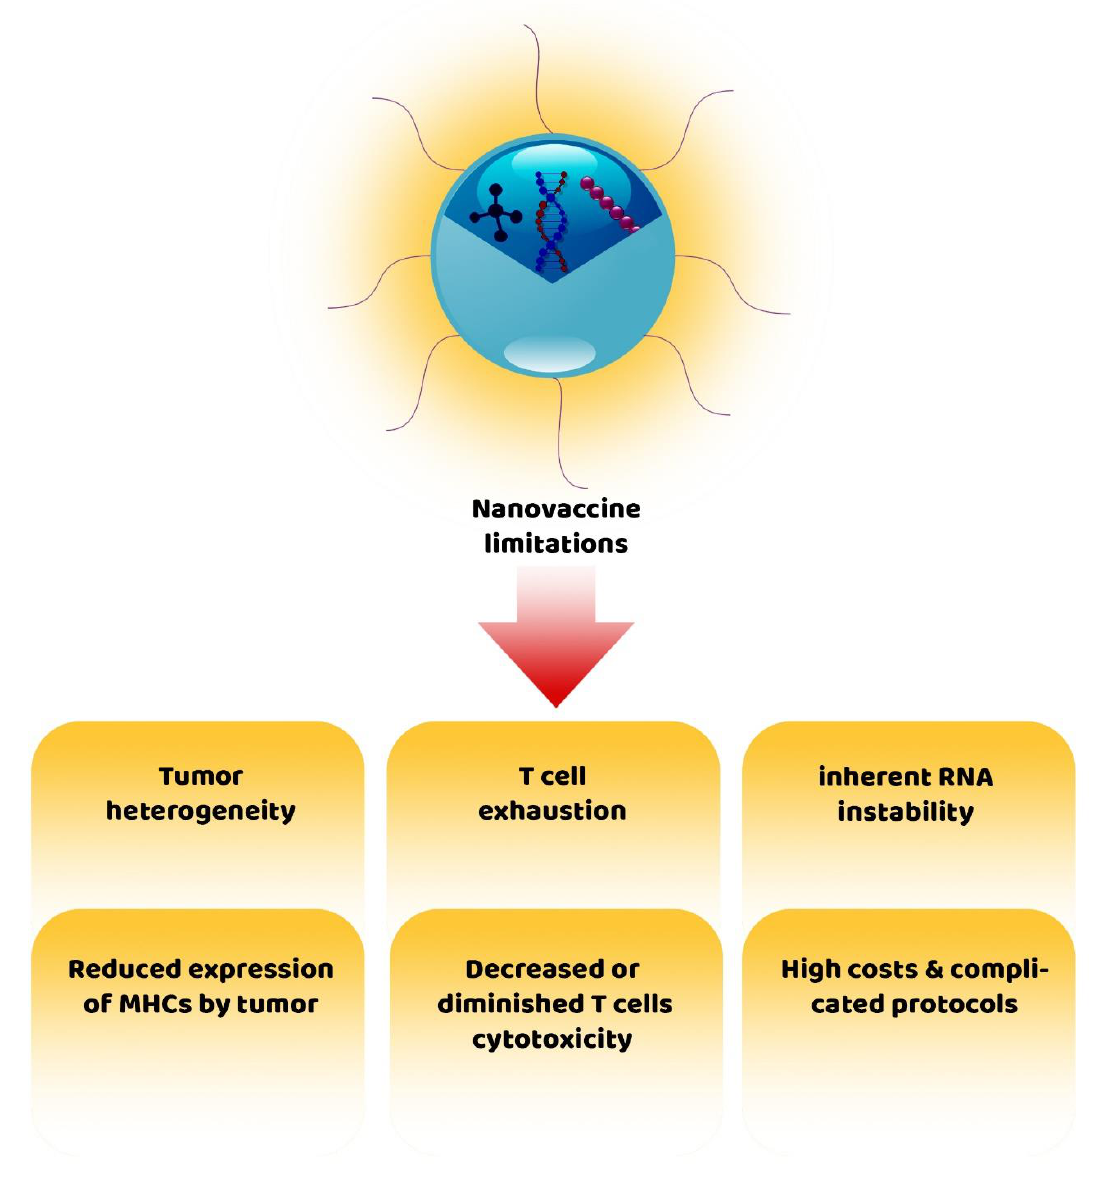
Figure 3. Challenges and limitations of cancer treatment with nanovaccines.